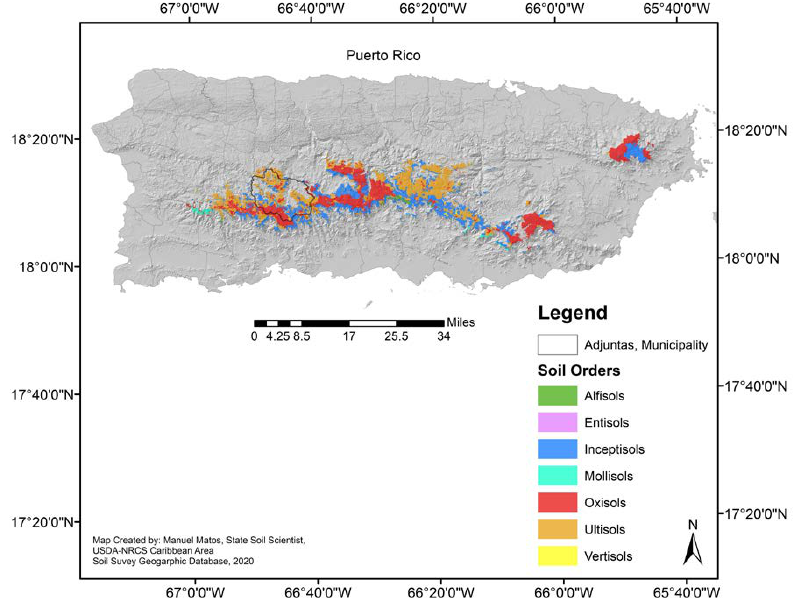
Figure 1. Land-area above 600 m in Puerto Rico and its predominant soil orders (Data and Map generated by Manuel Matos-Rodríguez, State Soil Scientist, USDA-NRCS Caribbean Area, 2019). This figure cannot be used in a publication before requesting authorization of Manuel Matos-Rodríguez.